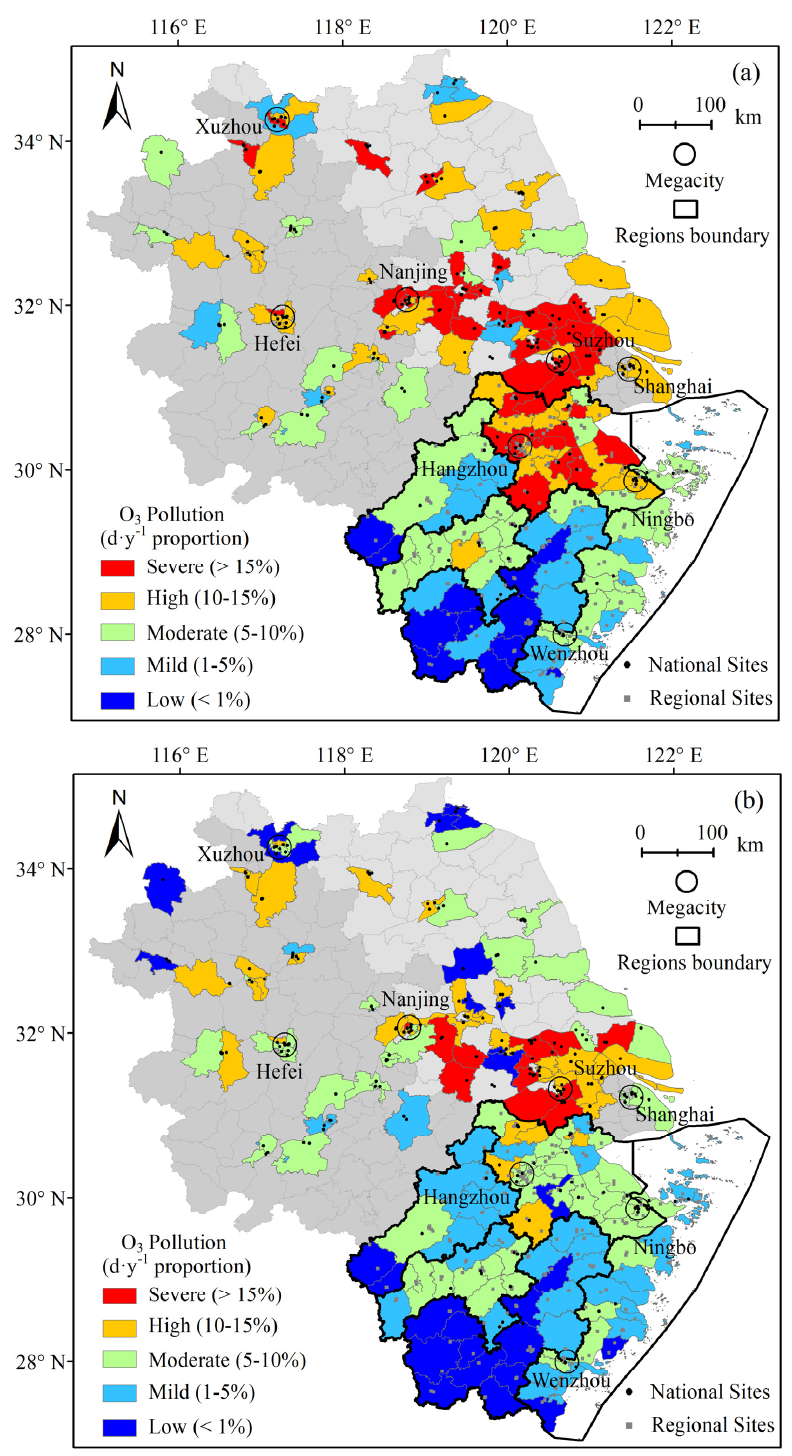
Figure 2. Spatial distribution of O 3 pollution in ( a ) 2015–2021 and ( b ) 2020 over each county generated with the measurements from the dense ambient stations over the Yangtze River Delta. Megacities with residents more than 9.0 million in 2021 shown with black circle. The separated regions of Zhejiang province are highlighted with black